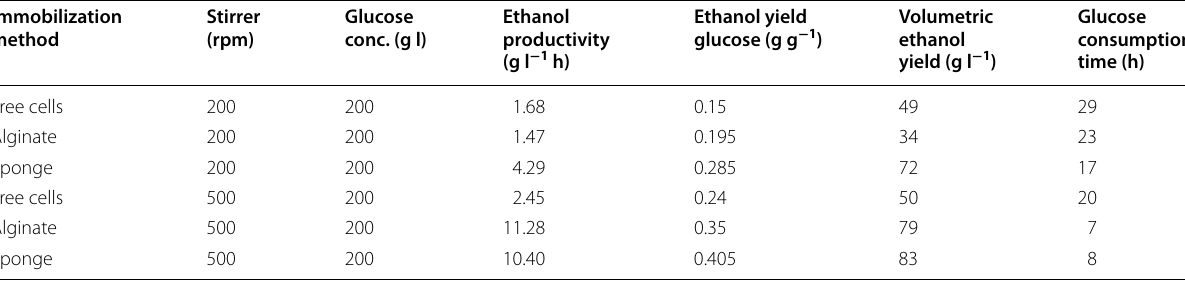
Ethanol yield (g g − 1 ) and Ethanol productivity (g l − 1 h) refer Eqs. (1) and (2)